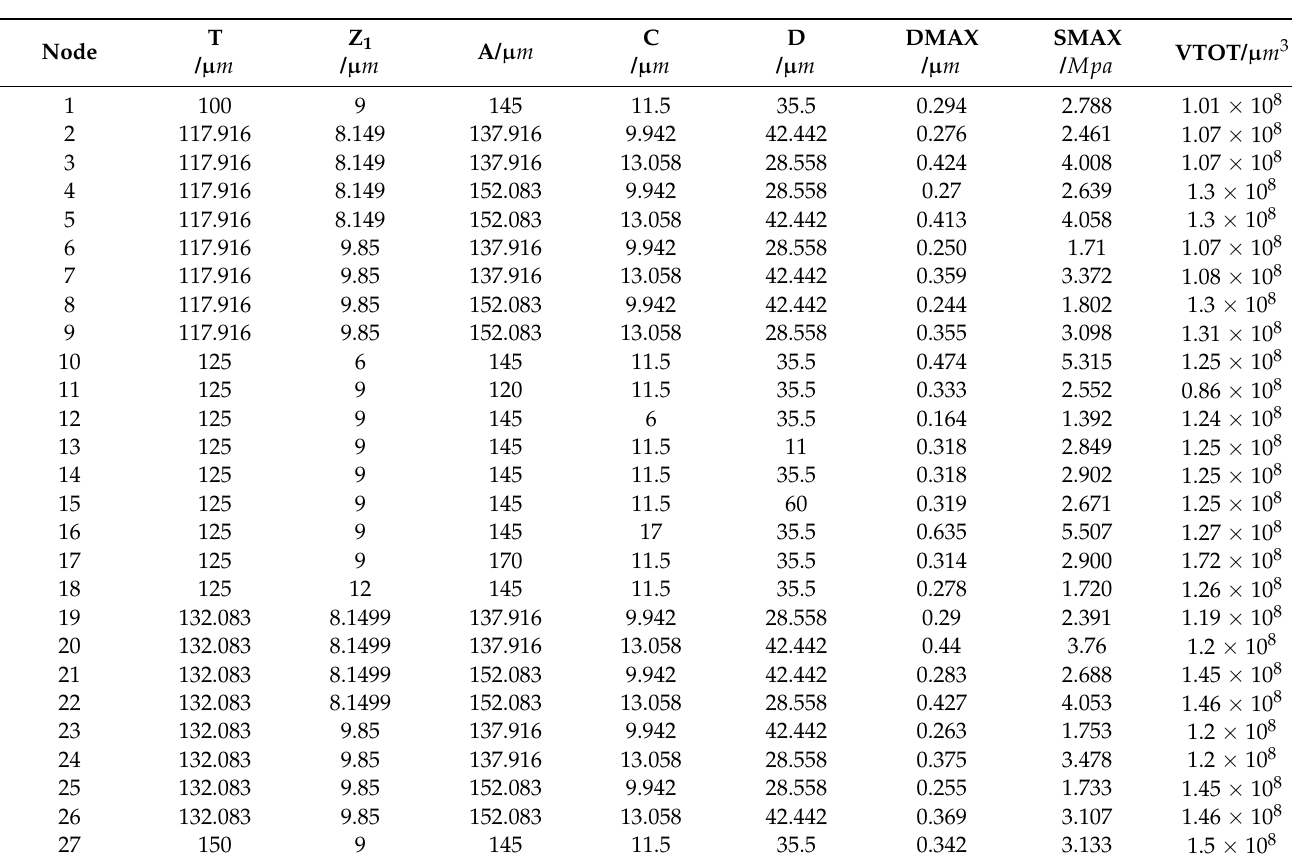
Table 2. Numerical experiment design and calculated